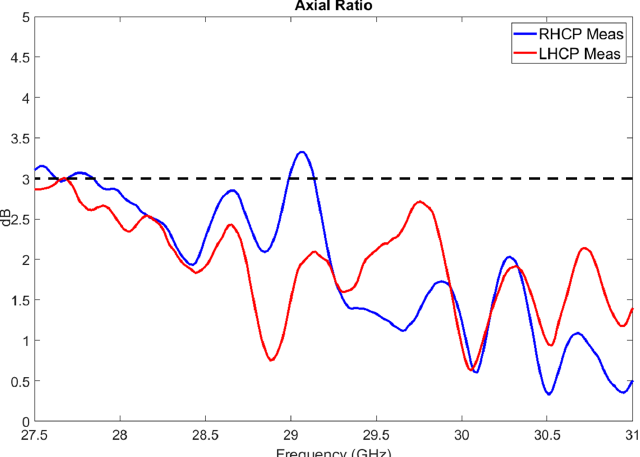
Figure 11. Axial ratio measurements for the 2 × 2 array normalized radiation patterns at φ = 0° for RHCP and LHCP.